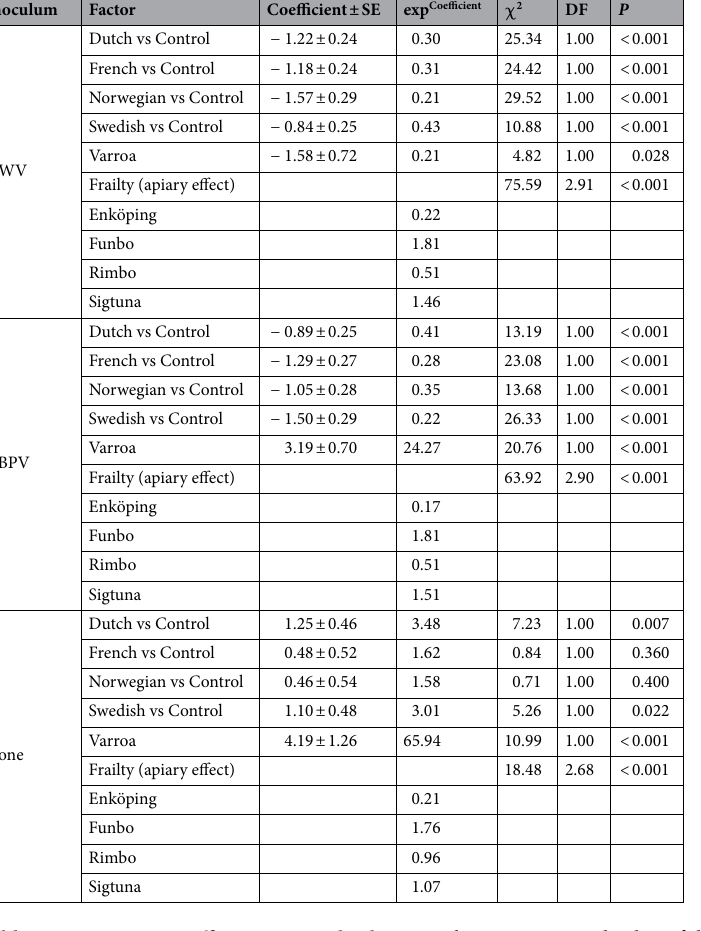
the Chi-squared value ( χ 2 ), degrees of freedom ( DF ) and the associated probability of obtaining these χ 2 values by chance ( P ) from Cox proportional hazards models describing the probability of mortality for individual bees after being inoculated ( Inoculum ) with DWV or ABPV, as well as for non-inoculated bees (none). The main Factors explored for explaining the variation in the data are differences between the varroa- susceptible Control population and each of the four varroa-resistant populations (Dutch, French, Norwegian and Swedish), as well as the effect on adult survival of the phoretic varroa infestation rates of the colonies when the experimental adult bees were sampled (Varroa) and the apiary location of the colonies at SLU’s Lövsta Research Station ( Frailty ), with exponentiated coefficients for each of the four apiaries (‘Enköping’, ‘Funbo’, ‘Rimbo’ and ‘Sigtuna’). The exponentiated coefficients converts the regression coefficients to a proportional scale, where values < 1.00 represent a lower mortality due to the factor, and values > 1.00 a higher mortality. The effects of the four apiaries concern relative internal differences, with the exponentiated coefficients